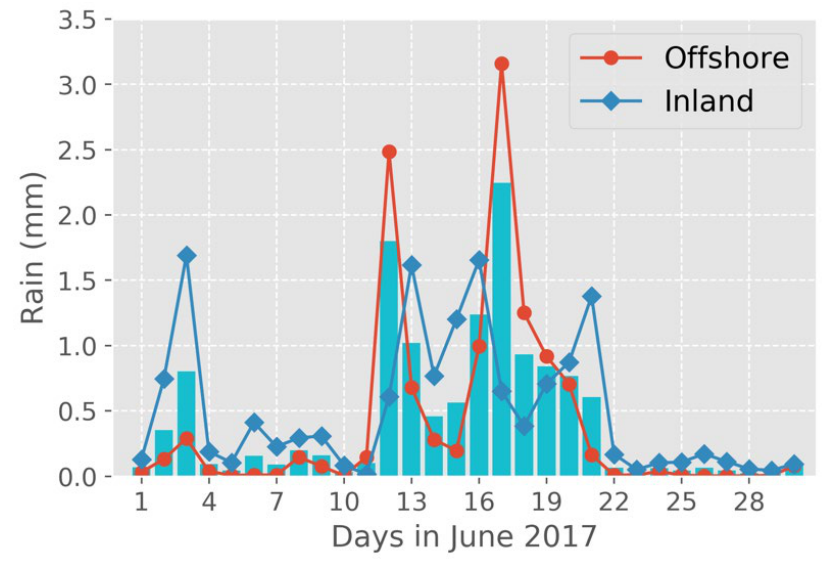
Figure 1. Daily rainfall amount over the South China coastal area (SCCA, cyan bar), including offshore and inland regions, as denoted by red and blue markers, respectively.